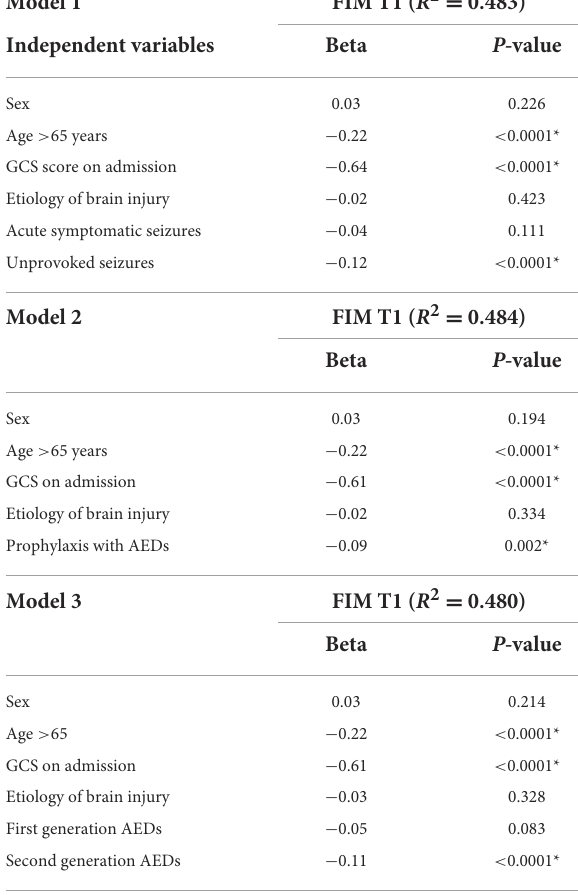
TABLE 4 Multiple linear regression models for independent predictors of functional outcome according to brain injury, prophylactic use and AED